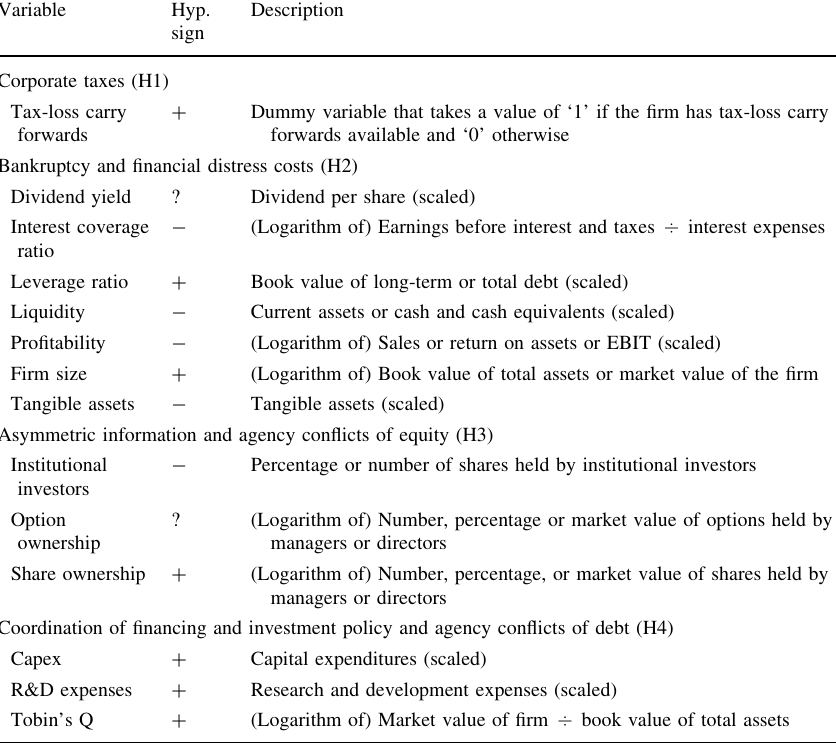
Table 2 Summary of proxy variables for the determinants of corporate hedging Variable Hyp.